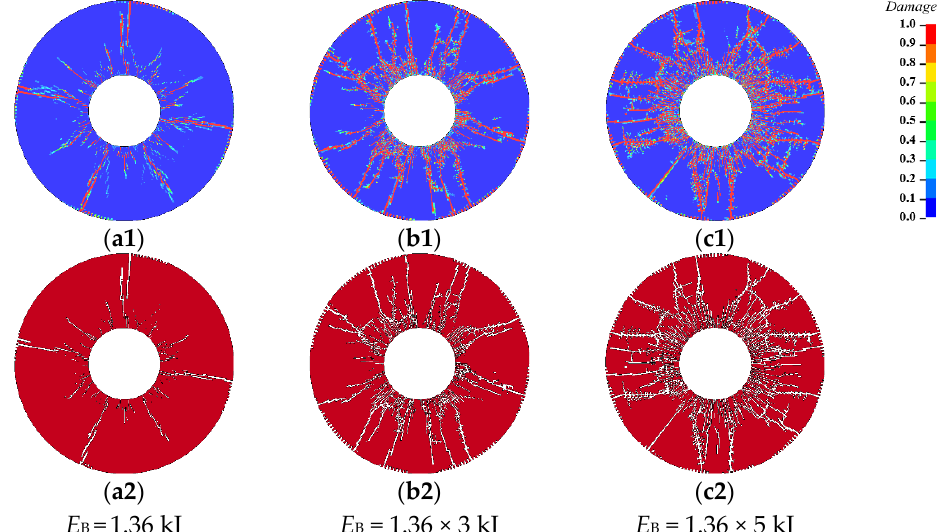
Figure 16. Damage distribution ( a1 , b1 , c1 ) and crack pattern ( a2 , b2 , c2 ) under different discharge energies when P c = 1 MPa and P h = 0 MPa.